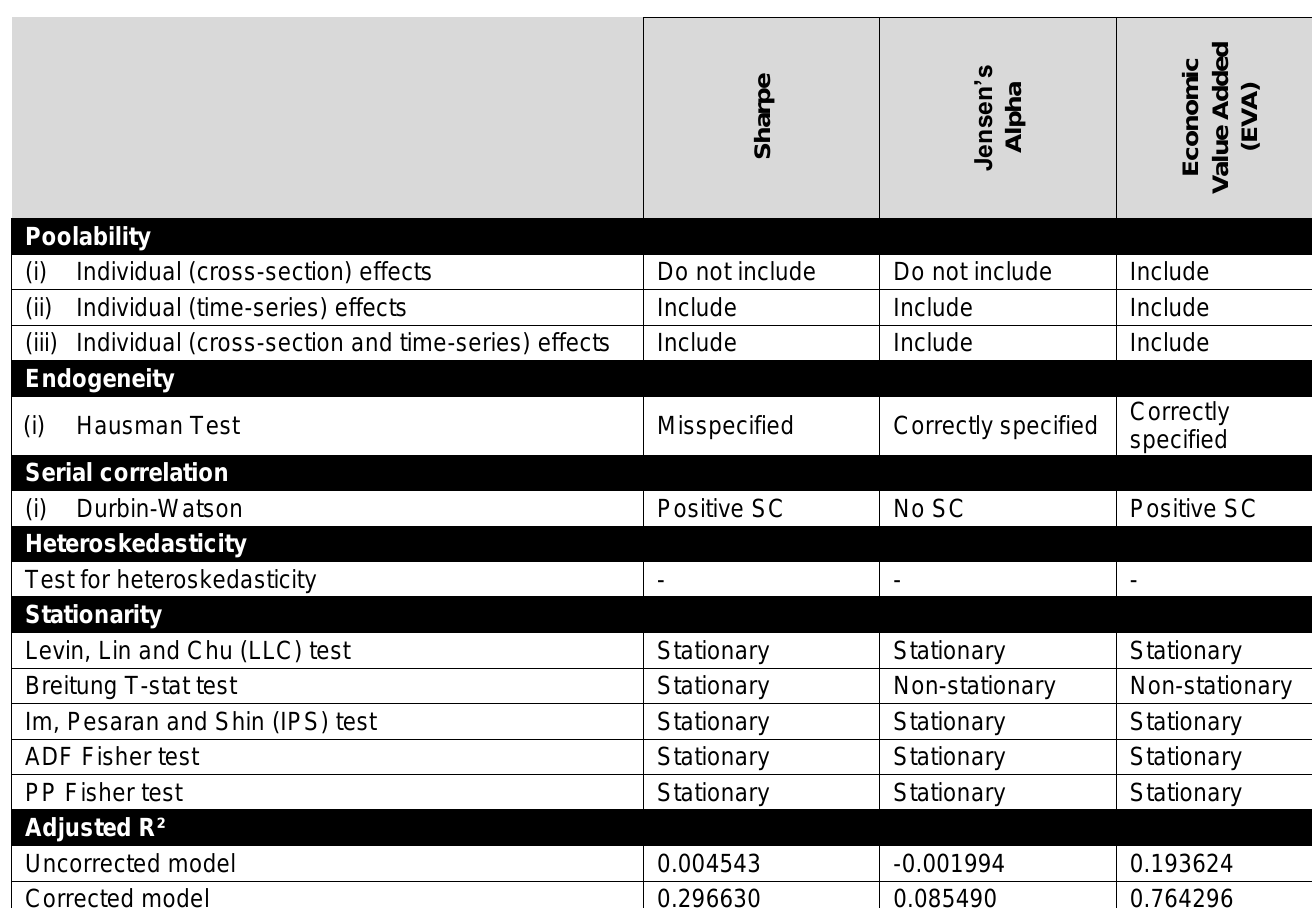
Table 2: Summary of